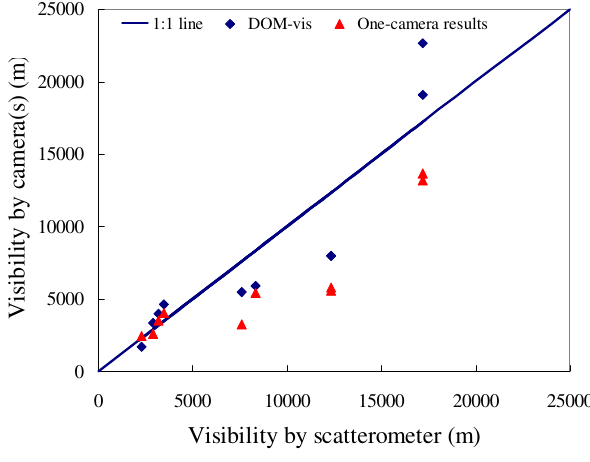
Figure 9. Comparison of DOM-Vis and one-camera digital photographic method 501 Fig. 9. Comparison of DOM-Vis and one-camera digital photo- graphic